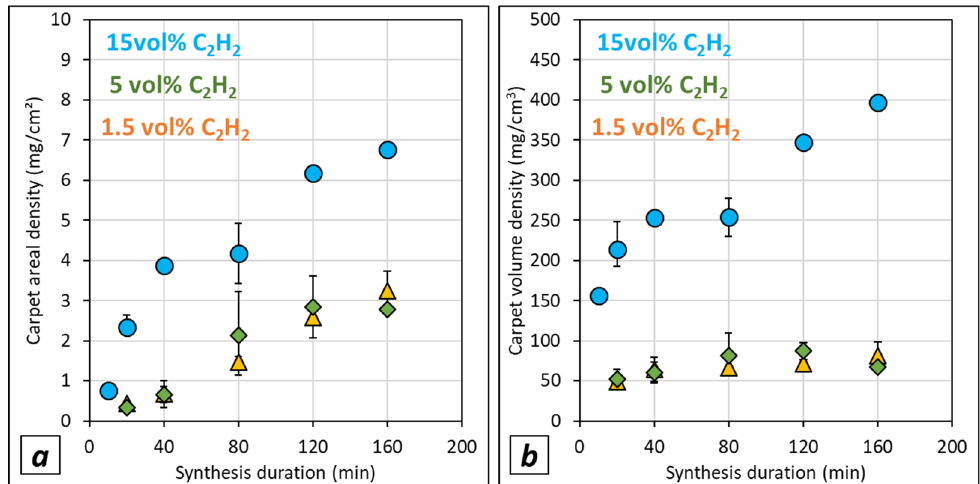
Figure 8. Carpet density calculated from the sample weights on the two faces of the LG-Al substrates (P5) after synthesis from various acetylene contents (15 vol% blue dots, 5% vol% green diamond, 1.5 vol% yellow triangles) performed in the (20–160) min duration range: ( a ) areal density, ( b ) volume density, both drawn versus synthesis duration. When indicated, variation range around the mean value is calculated from at least 2 synthesis experiments performed in the same conditions, and corresponds to the minimum and maximum of the mean value.